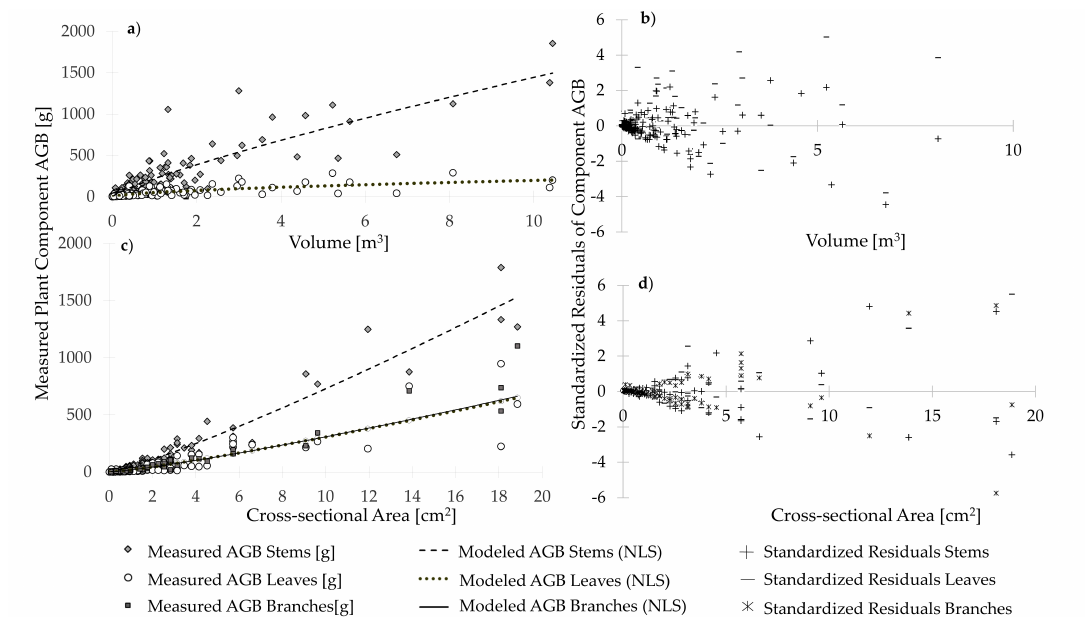
Figure 4. Model fits and standardized residuals per plant component for multi-species ( a , b ) shrub and ( c , d ) short-stature tree AGB. Shrub and tree component AGB was modeled via iterative nonlinear least-squares regression, using volume and cross-sectional area as the predictor variable,